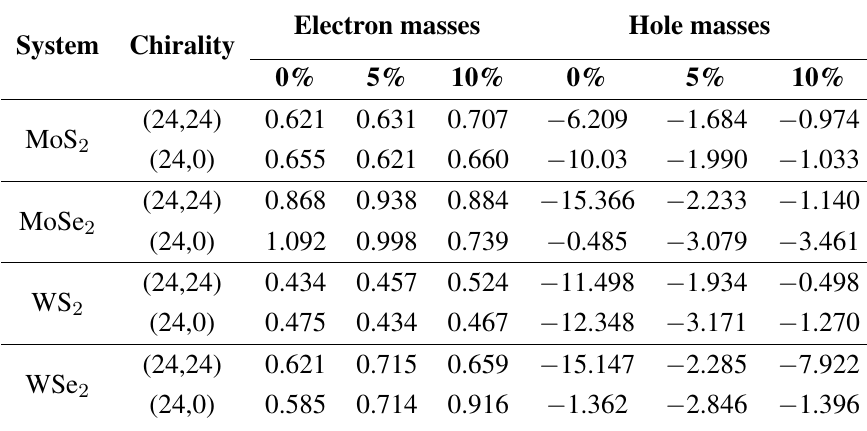
Table 2. The calculated effective electron and hole masses (in m respect to the applied tensile strain ( ε ). For zigzag NTs, both effective masses are calculated at the Γ point; for armchair NTs, effective masses of holes are calculated at Γ and of electrons between Γ and X . Note, for the latter, we do not specify the exact k -point as the conduction band minimum (CBM) shifts with ε . The negative values of hole effective masses come from the band curvature at the valence band maximum